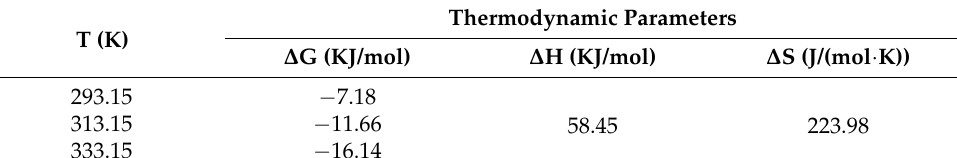
Table 7. Calculated thermodynamic parameters for ethyl acetate adsorption.